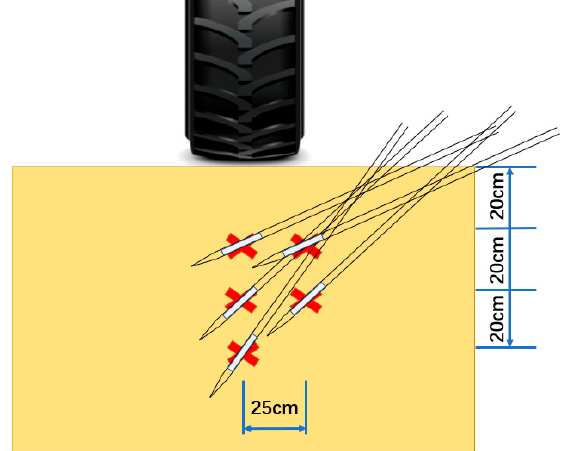
Figure 3. Installation position of Bolling probe to measure the mean normal stress in vertical (3 probes) and lateral (2 probes) directions. The three probes in the vertical direction and the two probes in the lateral direction were staggered during the installation, with 25 cm between two groups.